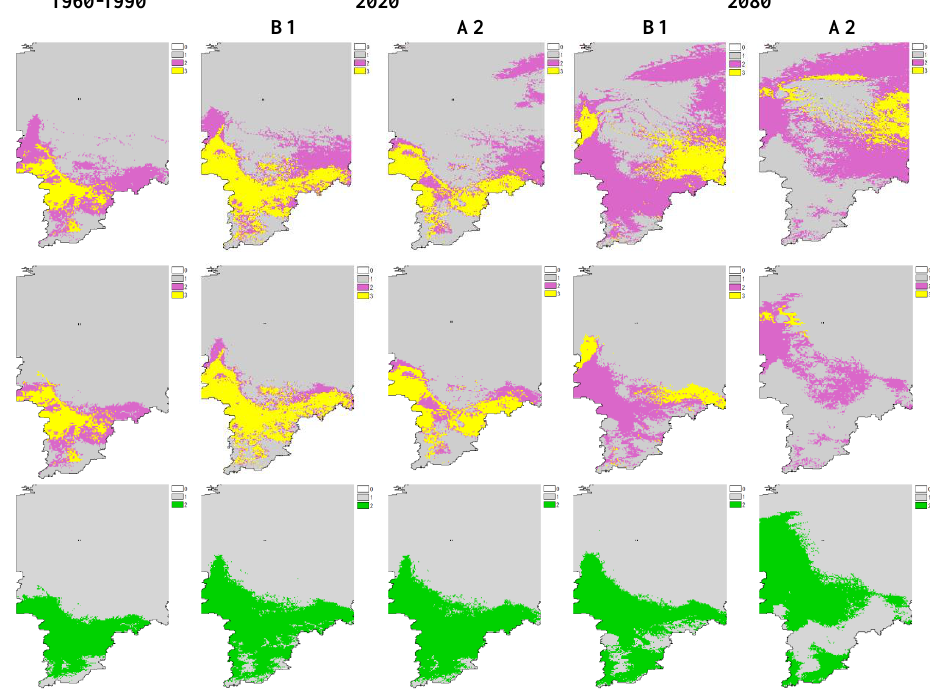
Figure 1. Potential (upper) and realized (corrected with regard of the Pinus sylvestris range, middle) ranges of Lophodermium needle cast and the Pinus sylvestris range (Tchebakova and Parfenova, 2012, lower) in the baseline 1960–1990 and HadCM3 B1 and A2 warmed climates at 2020 and 2080. 1 – no needle cast; 2 + 3 – needle cast range; 3 – needle cast